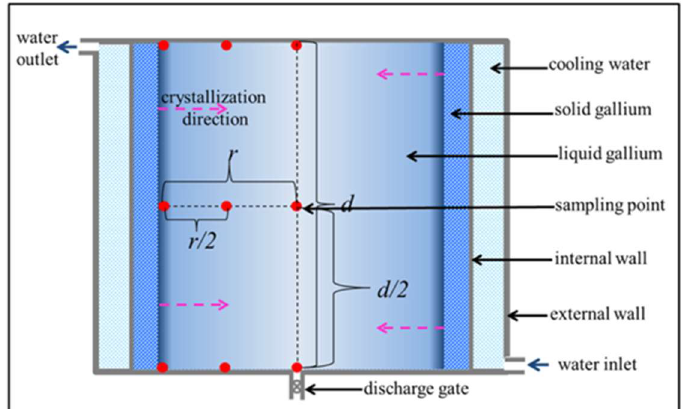
Figure 1. Schematic of the refining process, where r is the distance from the solidification interface to the center of the crystallizer, and d is the distance between the top and the bottom of liquid Ga. Three kilograms of 4N Ga was molten at 338.15 K and washed with 150 mL, 3 mol/L HCl, and HNO 3 for 30 min